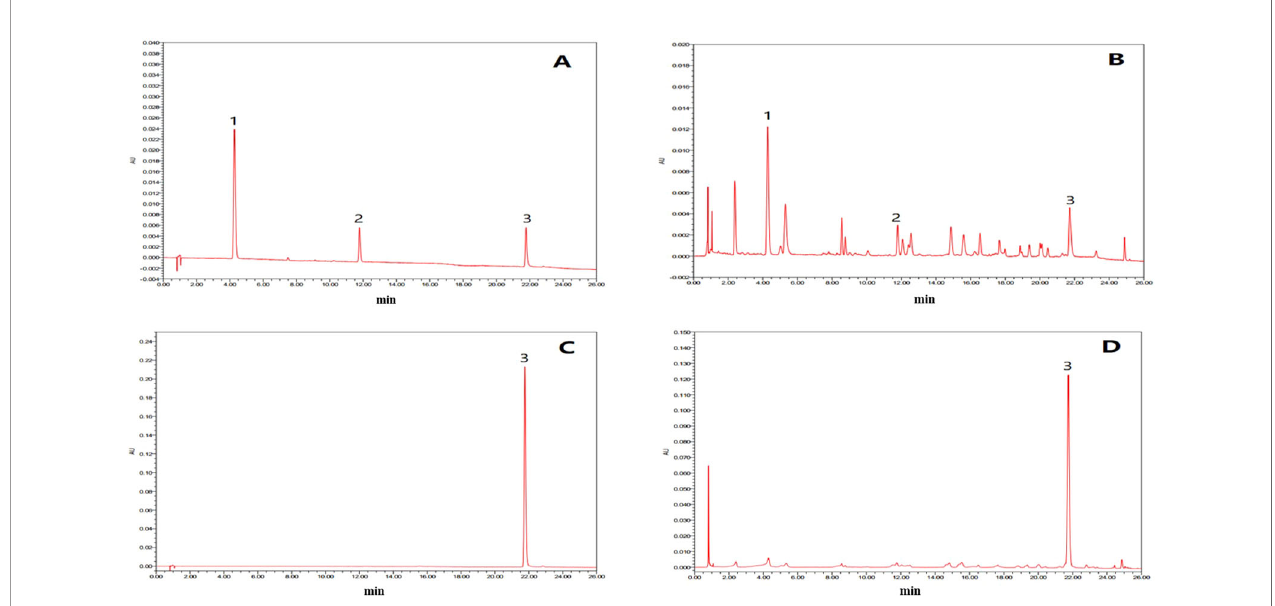
FIGURE 1 | UPLC chromatograms of chlorogenic acid, rutin, and tiliroside in WEE. (A) UPLC chromatogram of rutin, chlorogenic acid, and tiliroside dissolved in 50% methanol. (B) UPLC chromatogram of WEE sample dissolved in 50% methanol. (C) UPLC chromatogram of WEE sample dissolved in methanol. (D) HPLC chromatogram of WEE sample dissolved in methanol. Peaks 1, 2, and 3 represent chlorogenic acid, rutin, and tiliroside,